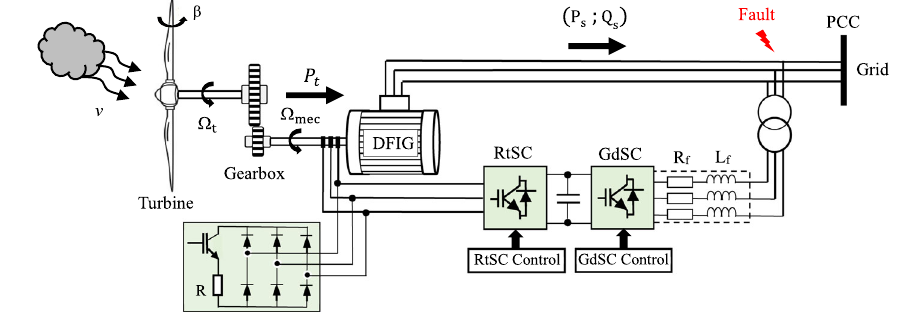
Fig. 3 DFIG based WT with the crowbar